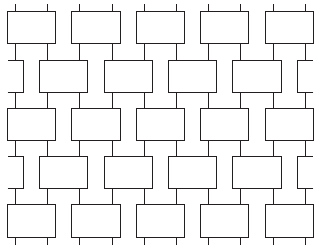
FIG. 3. The structure of the circuit with gates acting on nearest- neighbor sites. In the Floquet models we study, each gate is identical. In the random unitary case, each gate is independently sampled from the Haar